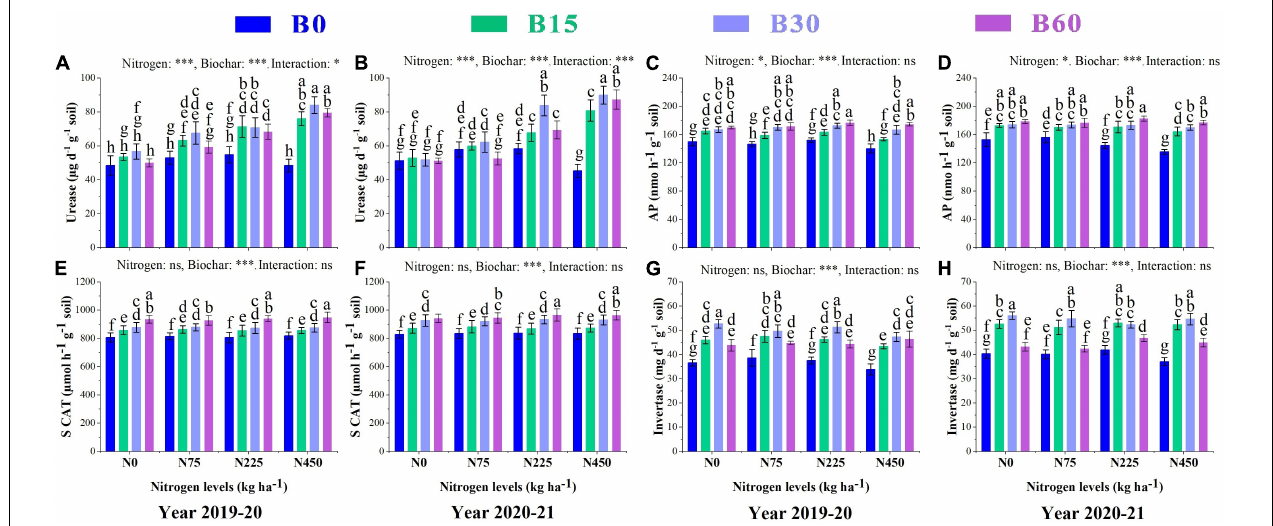
FIGURE 1 | Integral effects of biochar and nitrogen on soil urease (A) 2019–2020, (B) 2020–2021, alkaline phosphatase (C) 2019–2020, (D) 2020–2021, soil catalase (E) 2019–2020, (F) 2020–2021 and invertase (G) 2019–2020 and (H) 2020–2021. B0: 0 t ha − 1 biochar; B15: 15 t ha − 1 biochar; B30: 30 t ha − 1 biochar; standard error for each treatment in three replicates. Different letters on each bar represent significant difference according to LSD test ( p < 0.05).